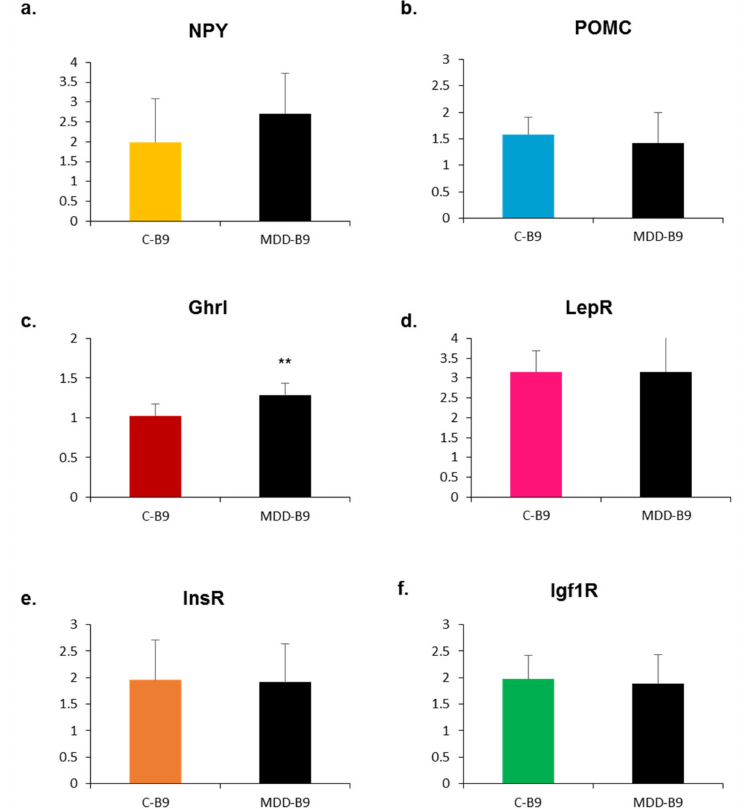
Figure 5. E ff ects of folate supplementation on mRNA expression of neuropeptides and receptors in the hypothalamus of rat pups at 21 days of age. Data are means ± SD from 6 ≤ n ≤ 8 individuals and are reported in arbitrary units. Statistically significant di ff erences between control (C-B9) and deficient (MDD-B9) rats: ** p < 0.01. ( a ) Neuropeptide Y (NPY); ( b ) pro-opiomelanocortin (POMC); ( c ) ghrelin (Ghrl); ( d ) leptin receptor (LepR); ( e ) insulin receptor (InsR); ( f ) insulin growth factor receptor 1